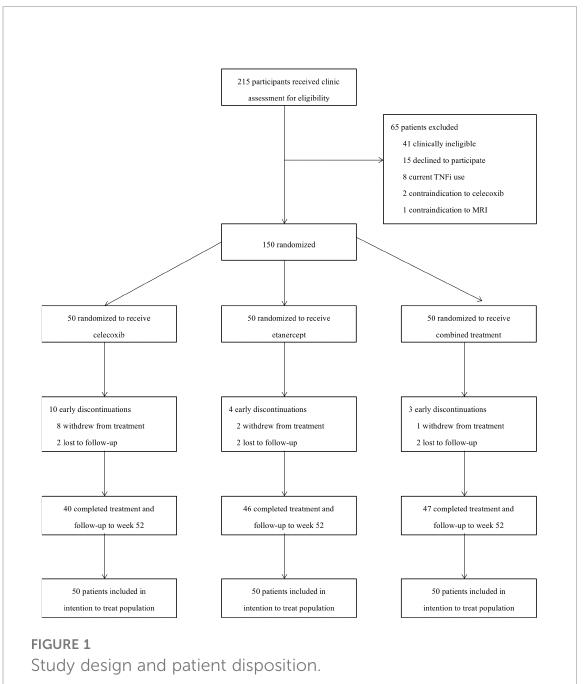
FIGURE 1 Study design and patient